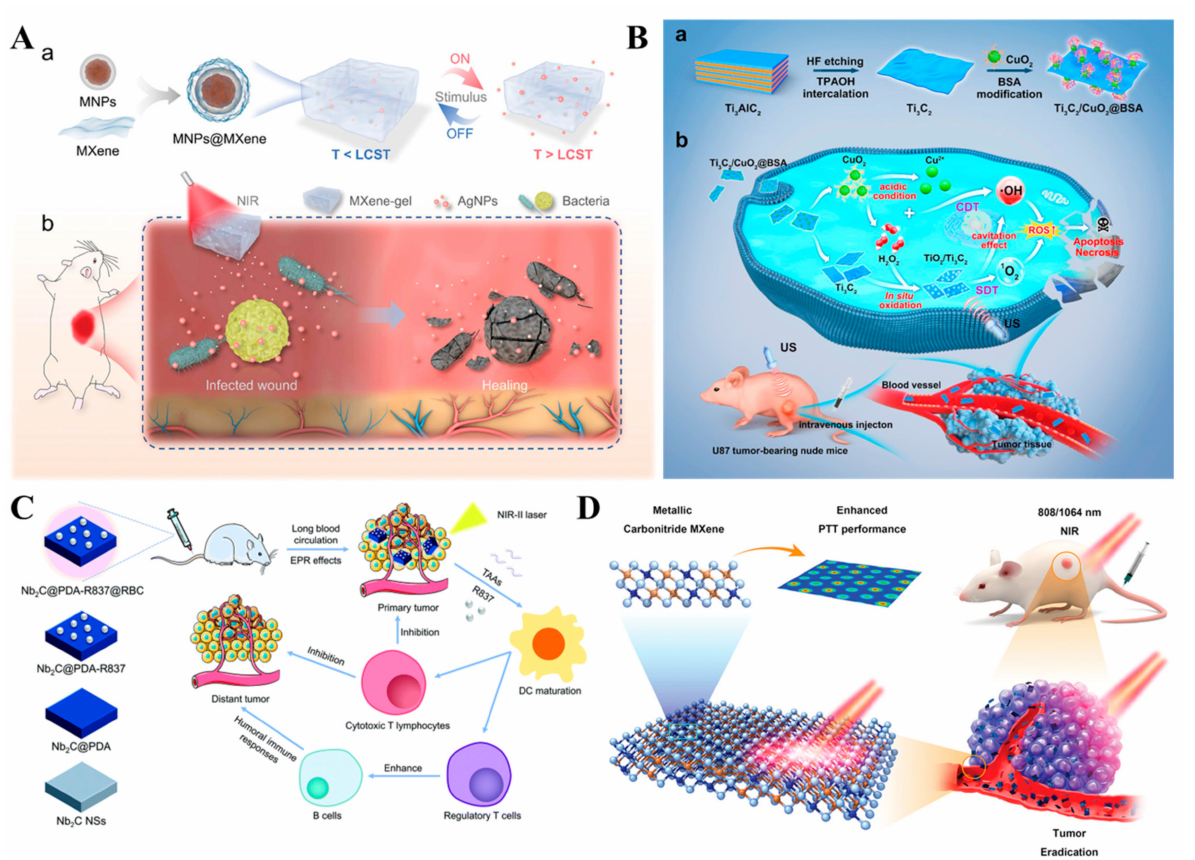
Figure 3. Schematic illustrations of ( A ) Functioning of stimuli-responsive MXene-hydrogel system. Drug release process of MXene-hydrogel ( a ), and deep chronic infected wound treated with MXene- hydrogel loaded with AgNPs ( b ). Reprinted with permission from Ref. [55]. Copyright © 2021 Wiley. ( B ) Synthesis of Ti 3 C 2 T x /CuO 2 @BSA nanosheets for the generation of in situ